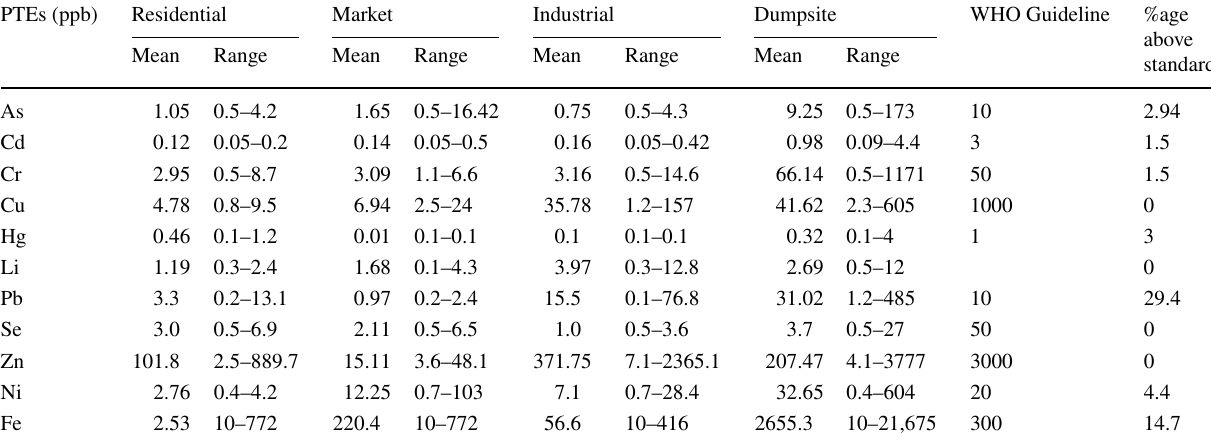
Table 2 Summary of results for potentially toxic elements in water PTEs (ppb)